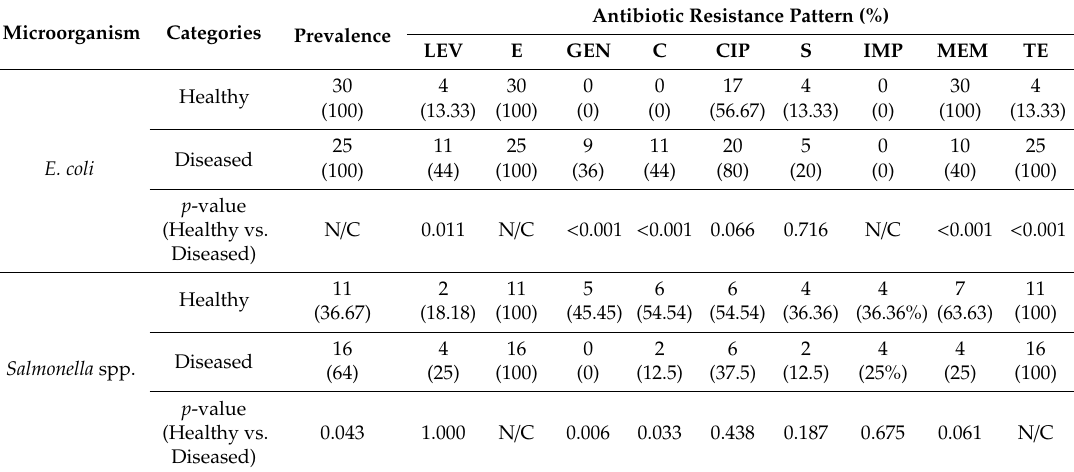
Table 1. Prevalence and resistance profiles of E. coli and Salmonella spp. isolated from